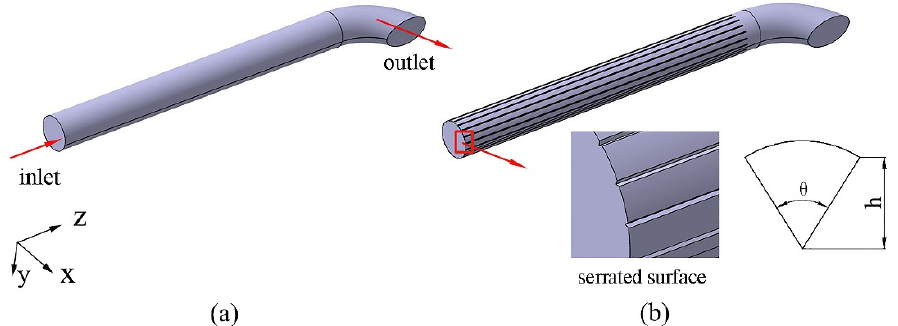
Figure 2. Three-dimensional diagram of air cavity: ( a ) prototype and ( b ) bionic exhaust tailpipe.